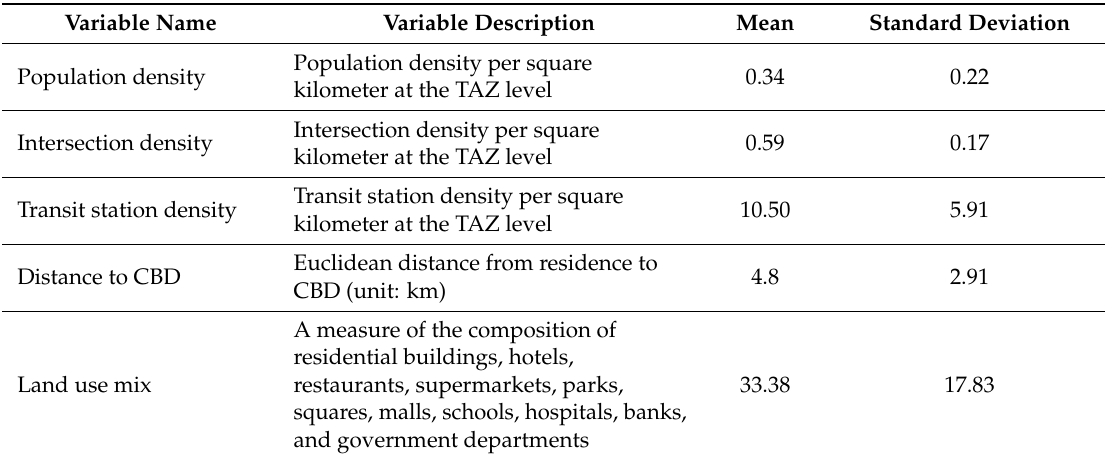
Table 2. Descriptive statistics of built environment